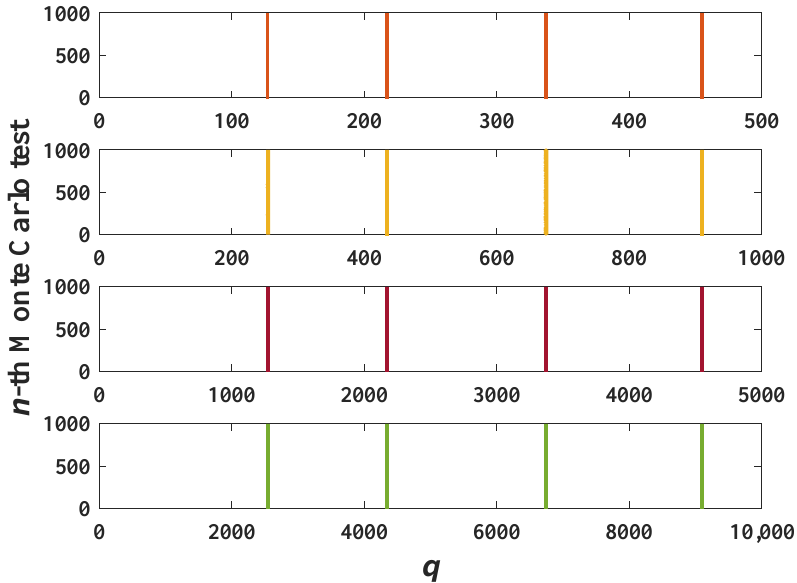
Figure 4. The location of the most highest four peaks obtained by the one-bit DFT method for 1000 Monte Carlo